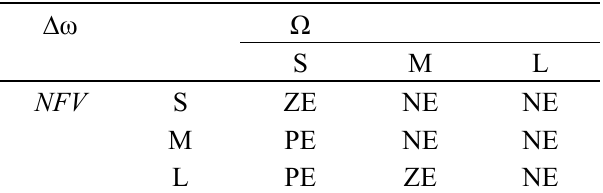
Table 1. Fuzzy rules for variations of the inertia